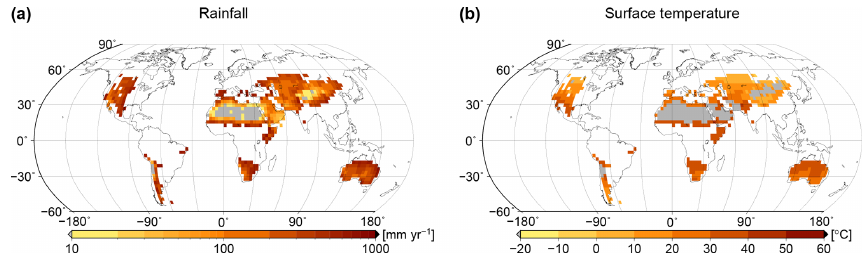
Figure A1. Global patterns of (a) rainfall and (b) surface temperature of biocrusts simulated by LiBry, in units of millimetres per year and degrees Celsius, respectively. White areas denote excluded regions, while grey areas correspond to regions where no simulated strategies are able to survive.